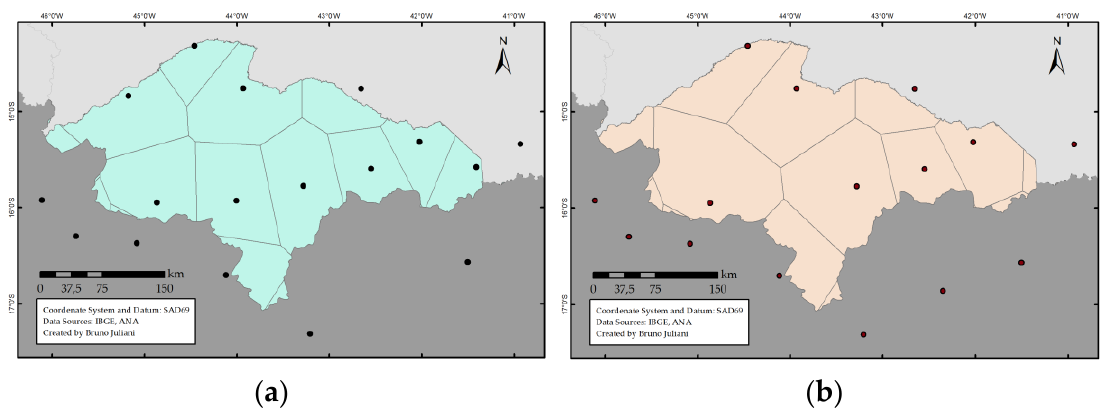
Figure 4. Thiessen polygon method for the semi-arid influence in Minas Gerais: ( a ) for a general application; ( b ) for 12-month drought events.